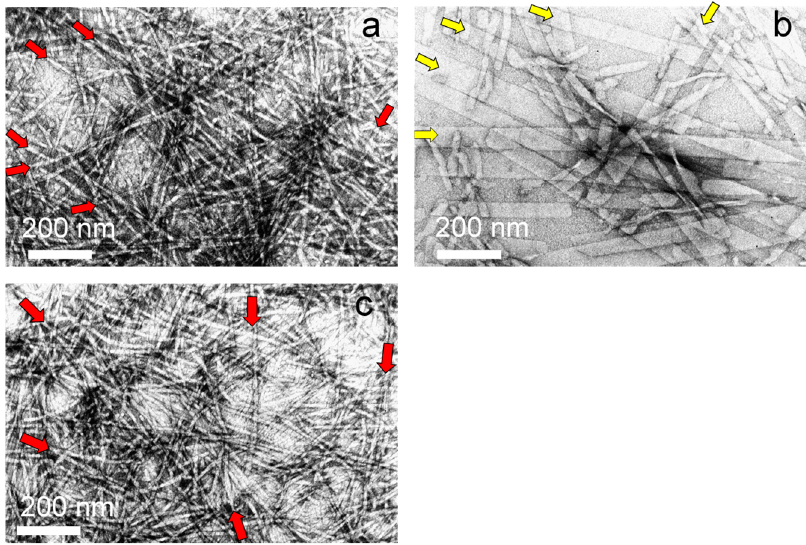
Figure 9. Negative-staining TEM images of the surfactant aqueous solutions at room temperature. Red arrows indicate rod-like aggregates, and yellow arrows indicate ribbon-like aggregates. Typical images of ( a ) 13-3-2-6 solution, ( b ) 13-4-2-6 solution, and ( c ) 13-5-2-6 solution.